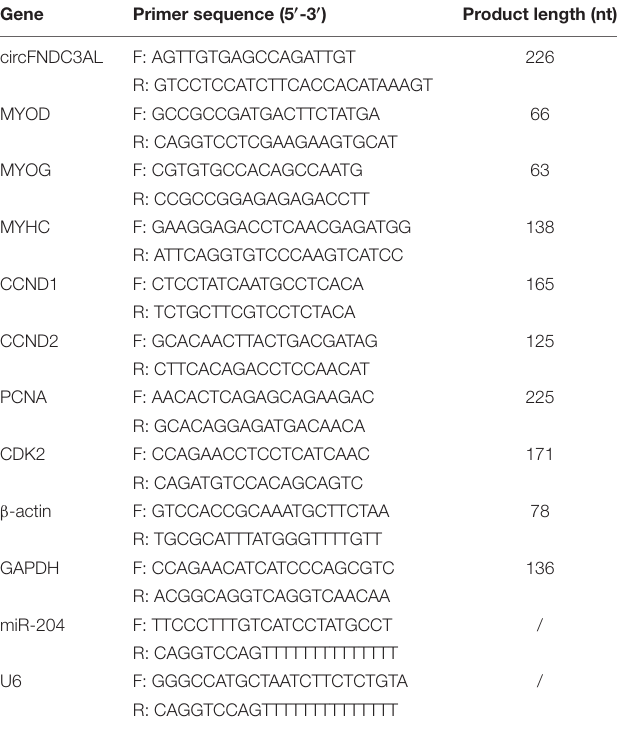
TABLE 1 | RNA oligonucleotides in this study. Name